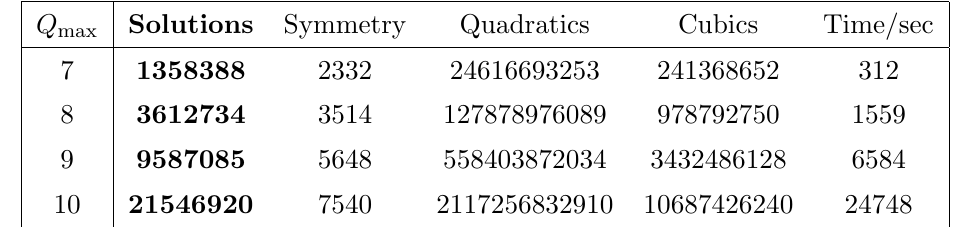
Table 1 . Number of inequivalent solutions to the anomaly equations for SM (cid:23) R fermion content and di(cid:11)erent maximum U(1) F charges 7 (cid:20) Q max (cid:20) 10. Each row contains the all-zero charge solution,